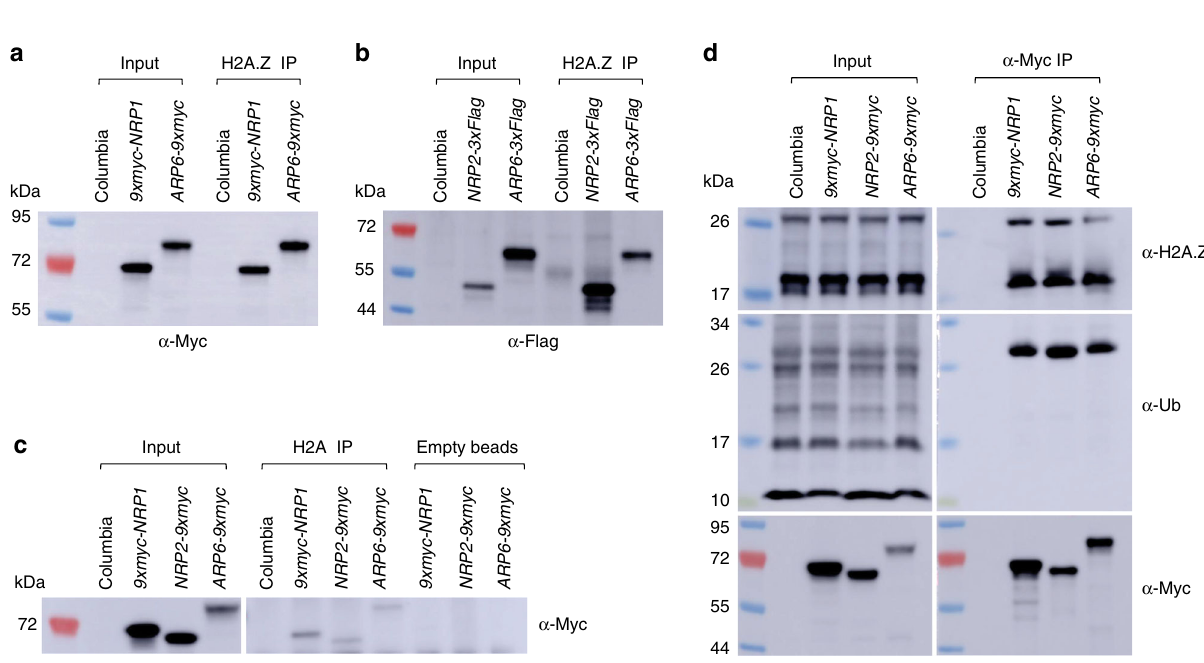
Fig. 2 NRP proteins physically interact with H2A and H2A.Z in vivo. a and b α -H2A.Z co-immunopuri fi cation assays; α -H2A.Z immunoprecipitation lanes ( = H2A.Z IP) show co-puri fi cation of H2A.Z with NRP1 ( a ) and NRP2 ( b ). c α -H2A co-immunopuri fi cation assays; α -H2A immunoprecipitation lanes ( = H2A IP), show co-puri fi cation of H2A with NRP1 and NRP2. We show empty beads as a negative control. d NRPs co-immunopuri fi cation assays; α -Myc immunoprecipitation lanes ( = Myc IP) show co-puri fi cation of NRP1 and NRP2 with both unmodi fi ed and monoubiquitinated H2A.Z. For each Western blot, the antibody used for detection is indicated either at the bottom, in the case of a and b , or to the right, in the case of c and d . In all cases, protein extracts from the same plants are included to con fi rm the identity of the co-precipitating band ( = Input). We included ARP6 as a positive control. All